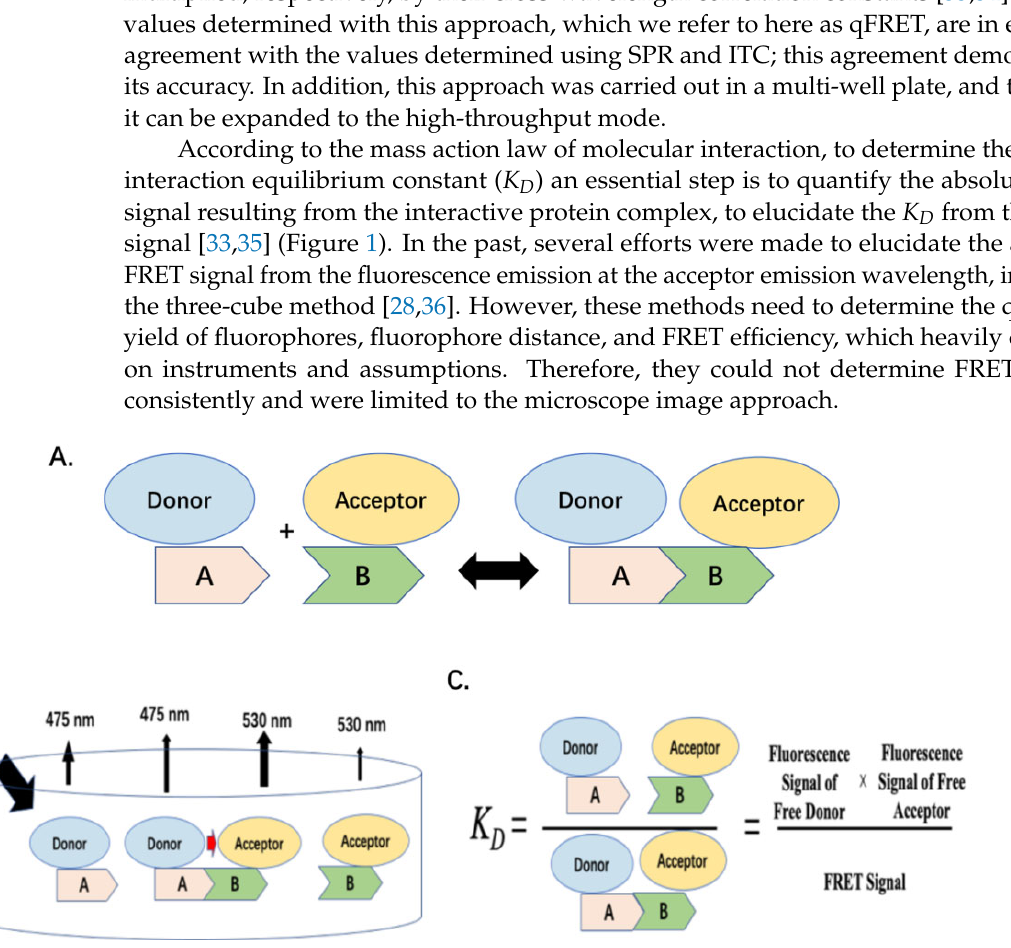
Figure 1. FRET ‐ based protein equilibrium constant K D determination: A. Mass action of protein ‐ protein interaction with FRET Figure 1. FRET-based protein equilibrium constant K D determination: ( A ). Mass action of protein-protein interaction label; B. Diagram of fluorescence signals of protein ‐ protein interaction in solution; C. Schematic diagram of FRET ‐ based protein with FRET label; ( B ). Diagram of fluorescence signals of protein-protein interaction in solution; ( C ). Schematic diagram of equilibrium constant K D determination. FRET-based protein equilibrium constant K D